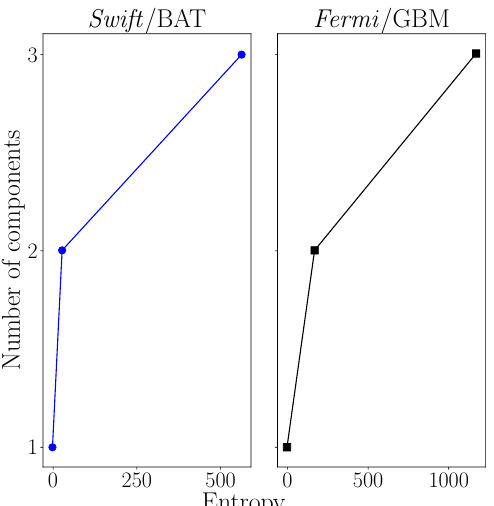
Figure 2. Entropy plots returned by clustCombi depicting the entropy of the initial MCLUST fits (three components) and the entropy after combination of the initial MCLUST components for Swift /BAT (left) and Fermi /GBM (right). An inflection, or elbow, in the entropy plot signifies a model with the optimal number of